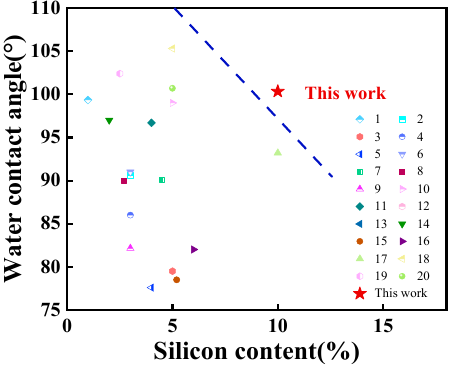
Figure 9. The maximum water contact angle of different research systems.